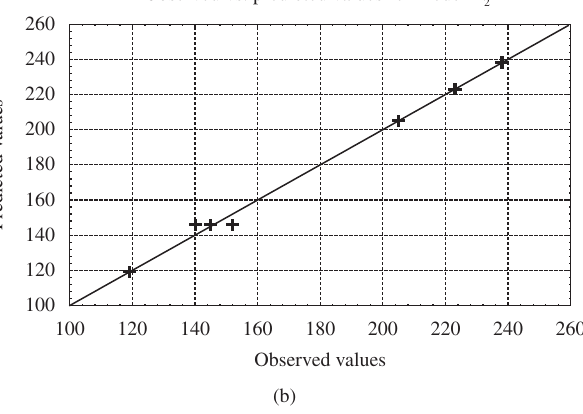
= microsphere di- 1 = standard 2